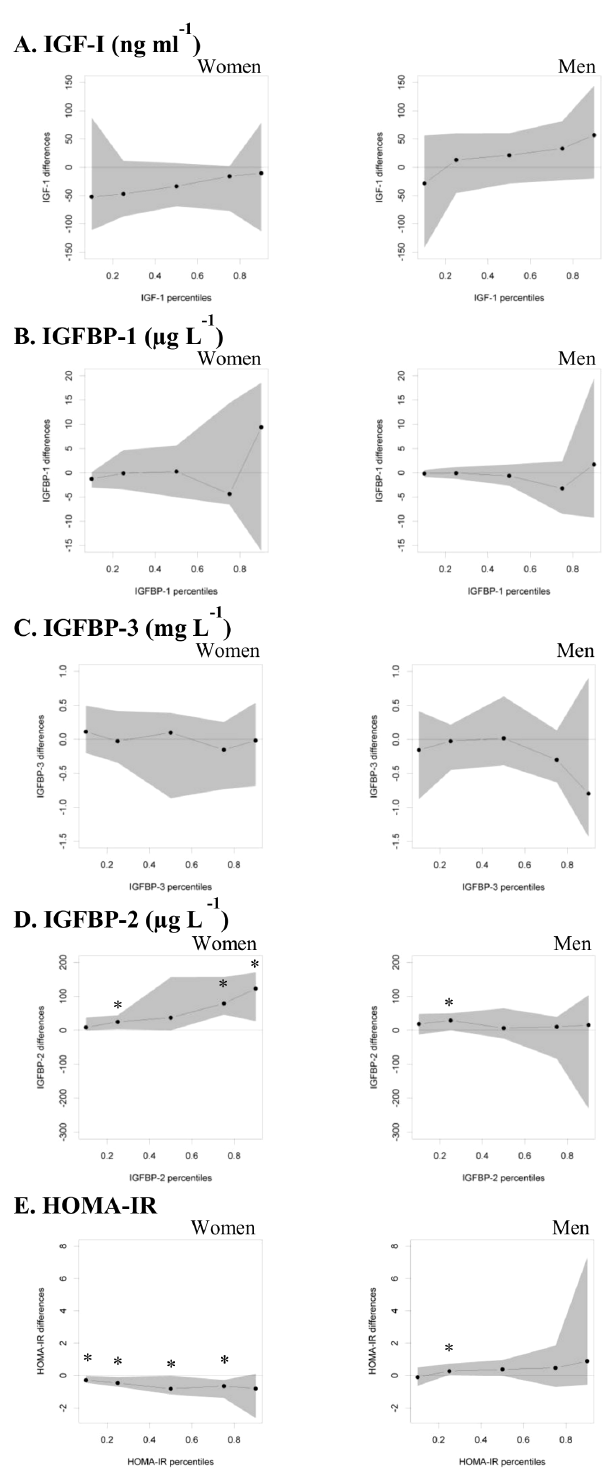
Figure 1. GH-IGF-axis and HOMA-IR in young adulthood according to breastfeeding duration in multivariable quantile regression models. Displayed are point estimates (95% CI) for IGF-I (A), IGFBP-1 (B), IGFBP-3 (C), IGFBP-2 (D) and HOMA-IR (E) differences between women and men breastfed for a long duration (i.e. . 17 weeks) vs. those not breastfed (i.e. # 2 weeks) for specific percentiles (10 th , 25 th , 50 th , 75 th and 90 th percentiles). Models included age in adulthood, maternal overweight (yes/no), paternal university